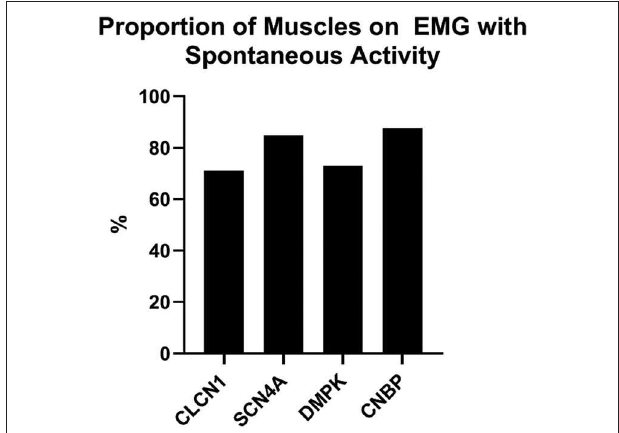
Creatine Kinase